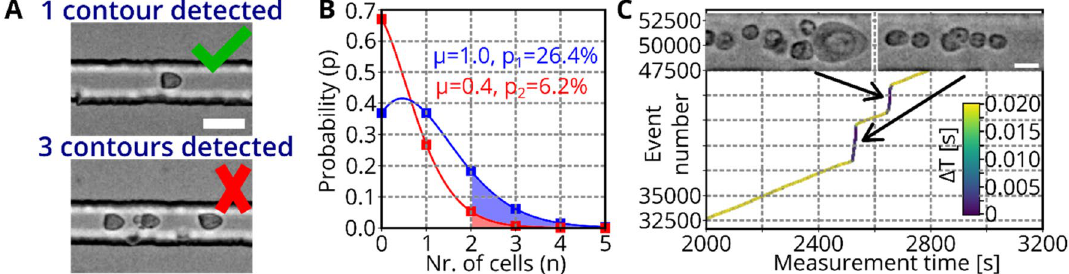
Figure 3. Detection and separation of cell aggregates. ( A ) Examples of images captured during sorting. A single contour is detected in the upper image, while three contours are detected in the lower image. Sorting trigger is omitted when more than one contour is detected. Scale bar: 20 µm. ( B ) The histogram shows the probability to have n cells in a unit volume. The chance of having more than one cell in the sorting region during a sorting pulse is 26.4% (blue) and 6.2% (red) for an initial cell concentration of 50 million cells/ml and 20 million cells/ ml, respectively. ( C ) Plot shows the measurement time and number of captured events of a measurement of Nrl- eGFP mice retina cells. Color code indicates the time difference between two events. While most of the time, events are captured with a time difference of > 0.02 s, during an avalanche, each captured frame contains cells, resulting in a time difference of approximately 0.00033 s = 0.33 ms. Scale bar: 10